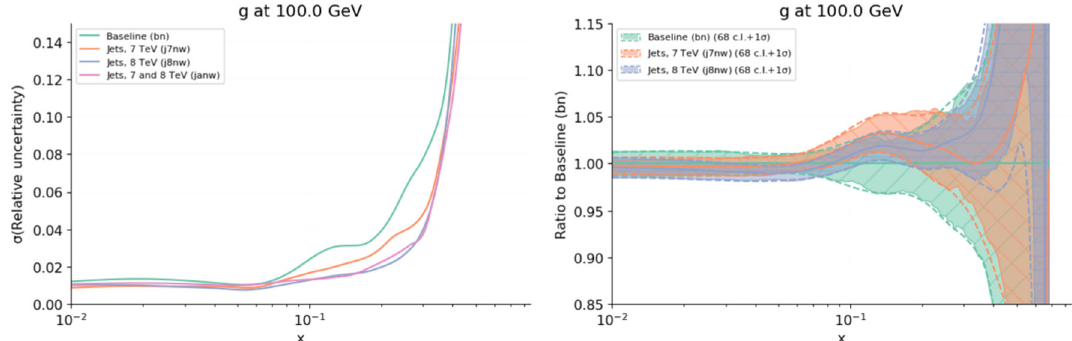
Fig. 7 Comparison between the baseline fit with no jet data (#bn), and the fits with only 7 TeV (#j7nw) or only 8 TeV (#j8nw) jet data included. The relative uncertainty on the gluon PDF (left) and the ratio